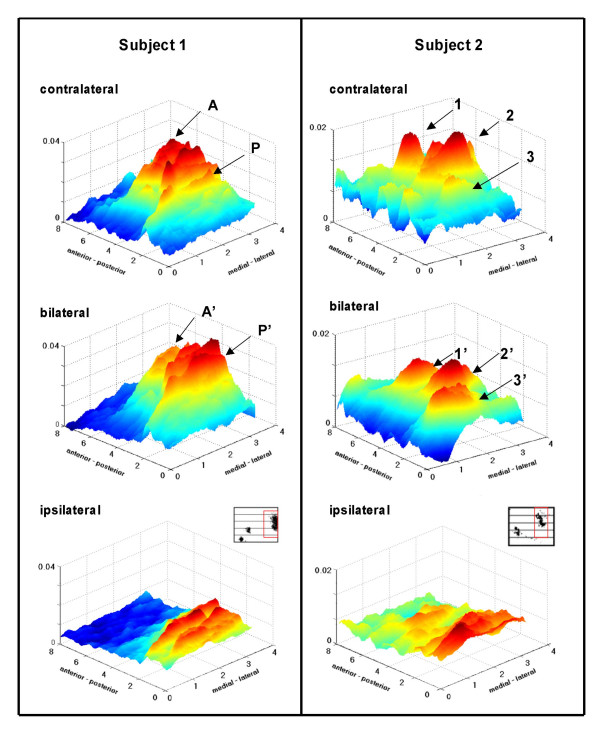
Comparison of contralateral vs. bilateral response in SII. Data displayed is a subset of the data displayed in Figure 1. Region of interest is indicated in figurines. X and Z axes are distance, indicated in mm (along either the anterior-posterior axis or medial-lateral axis). Y axis is absorbance. In Subject 1, note the increase in absorbance in the posterior region in the bilateral response, as compared to the contralateral response (P'>P). Also note the slight decrease in absorbance in the anterior region in the bilateral response relative to the contralateral response (A'<A). In Subject 2, note that in the modules identified in anterior SII (1 & 2), the absorbance value at loci 1 & 2 are greater than their counterparts in the bilateral response (1' and 2'). Module 3, on the other hand, is located in posterior SII (the region of maximal ipsilateral activation), and the absorbance values at 3' are much greater than the values at 3.